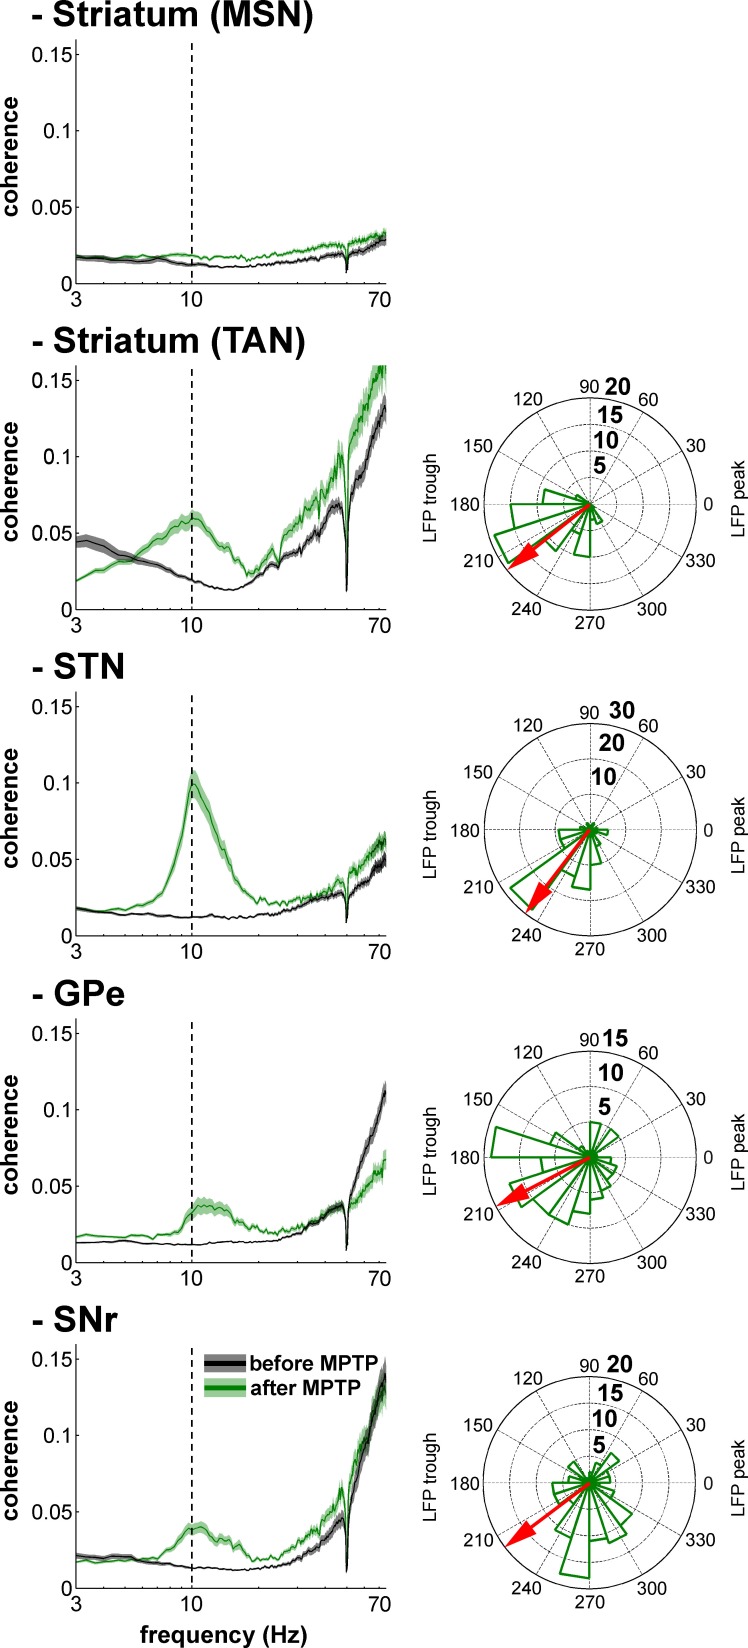
Single-unit spiking activity and LFP synchronization for the BG neuronal assemblies before and after MPTP intoxication.Left, average spike-field coherences between the spike train of the neurons (single-unit spiking activity) and the LFPs recorded in their vicinity before and after MPTP. Abscissas are in log scale. Right, phase histograms of the phases of the single-unit spiking activity relative to the LFP at the frequency of coherence peak values calculated in the 8–15 Hz range, after MPTP intoxication. The red arrows represent the mean phase of the spiking activity relative to the LFP peak (phase = 0 degree). Numbers in bold indicate the numbers of spike-LFP pairs. Given the absence of spike-field coherence for the MSNs after MPTP intoxication, the phase histogram of the MSN spike-LFP pairs was not calculated.DOI:
http://dx.doi.org/10.7554/eLife.16443.02410.7554/eLife.16443.025Figure 14—source data 1.Spike-LFP synchronization before and after MPTP.